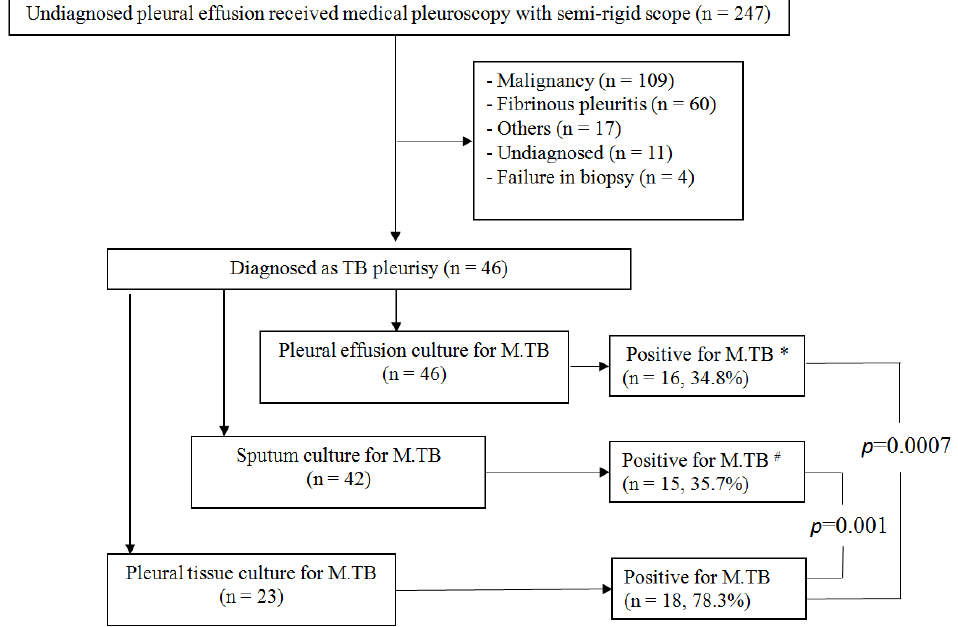
Figure 1. The diagnosis of patients that received pleuroscopic forceps biopsy; *, #: p < 0.05, statistical significance.